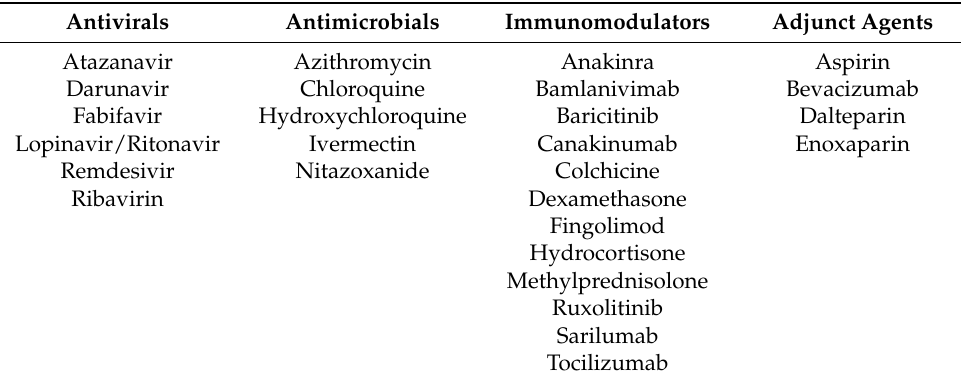
Table 1. Emerged drugs administered in COVID-19